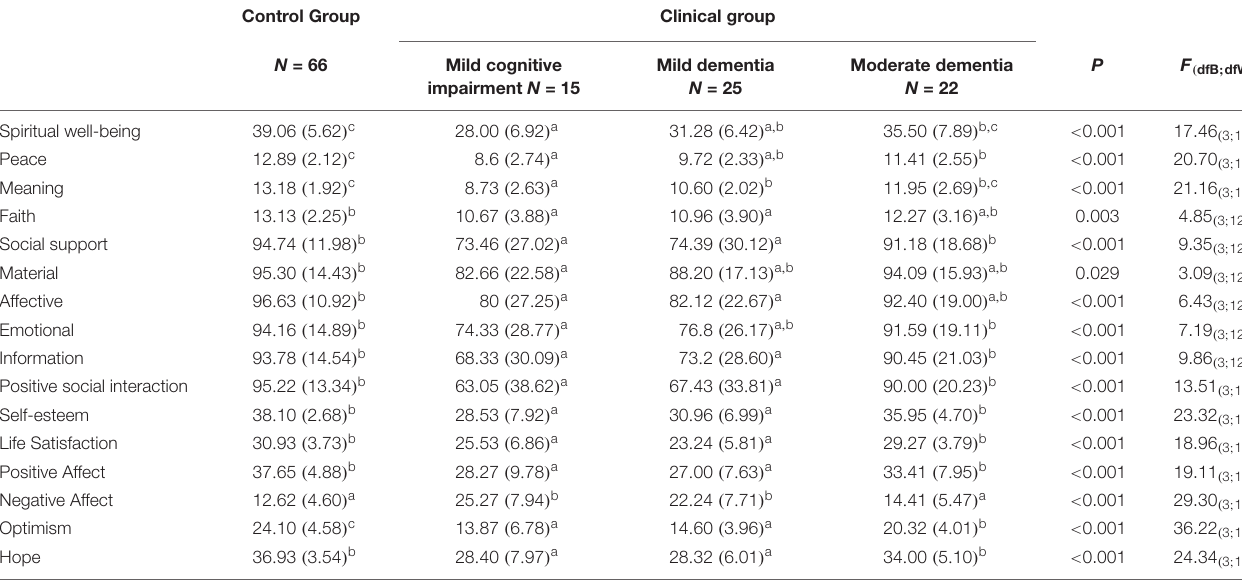
TABLE 2 | Comparison of mean and standard deviation in spiritual well-being, social support, self-esteem, life satisfaction, positive affect and negative affect, optimism and hope scores among healthy individuals with mild cognitive impairment and mild/moderate dementia. Control